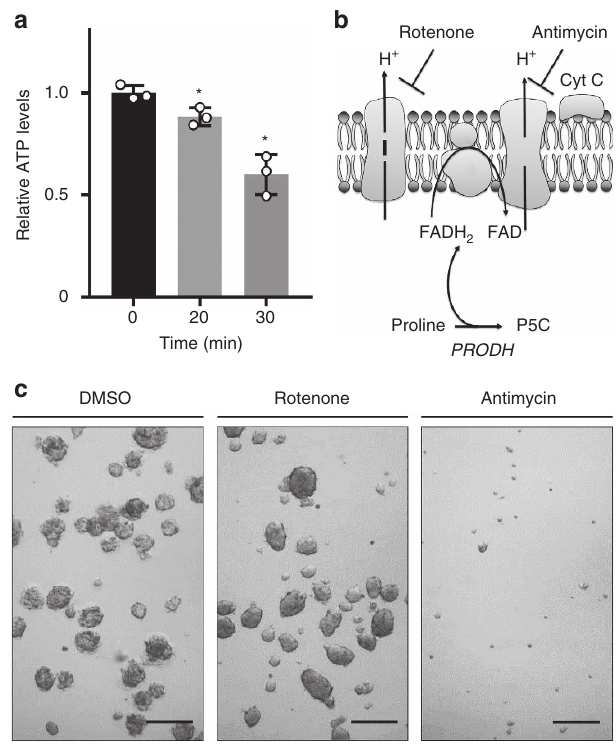
Figure 4 | Prodh activity generates ATP during 3D growth. ( a ) Time- resolved ATP levels of MCF10A H-Ras V12 spheroids upon treatment with the Prodh inhibitor L-THFA. ( b ) Schematic representation of Rotenone and Antimycin A mode of action as well as ATP generation from proline catabolism. ( c ) Representative pictures of MCF10A H-Ras V12 spheroids upon treatment with either rotenone or antimycin A. Treatment was started at day 0. Analysis was performed at day 5 of treatment. Scale bar: 150 m m. The number of biological replicates for each experiment was n Z 3. All error bars represent s.d. Two-tailed unpaired Student’s T -test was performed. * P r